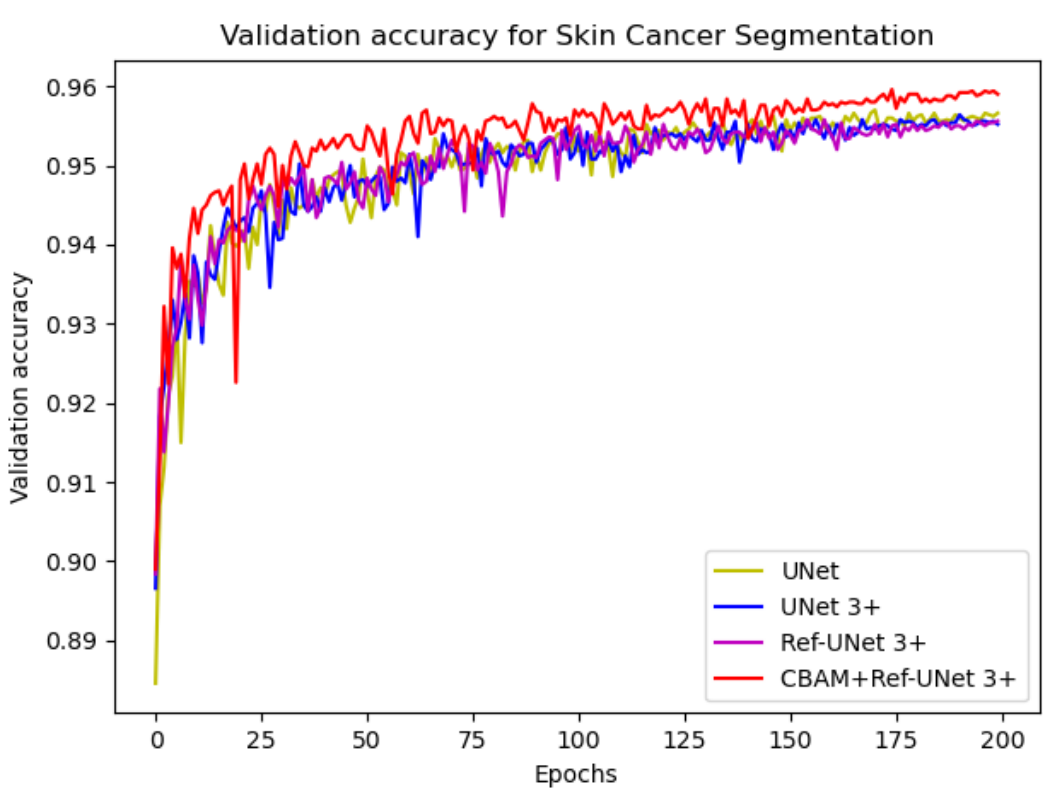
Figure 4. Comparison of training loss of different models for skin cancer segmentation.